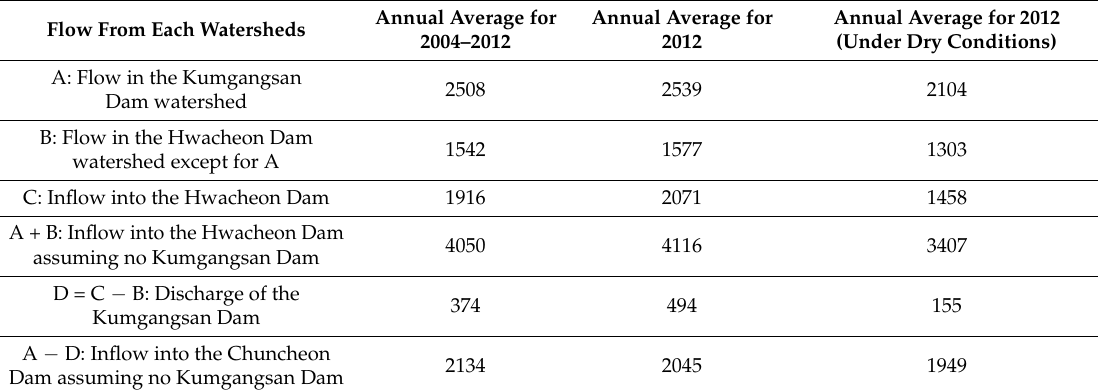
Table 5. Water budget analysis result for each dam. Unit: mm 3 y − 1 .